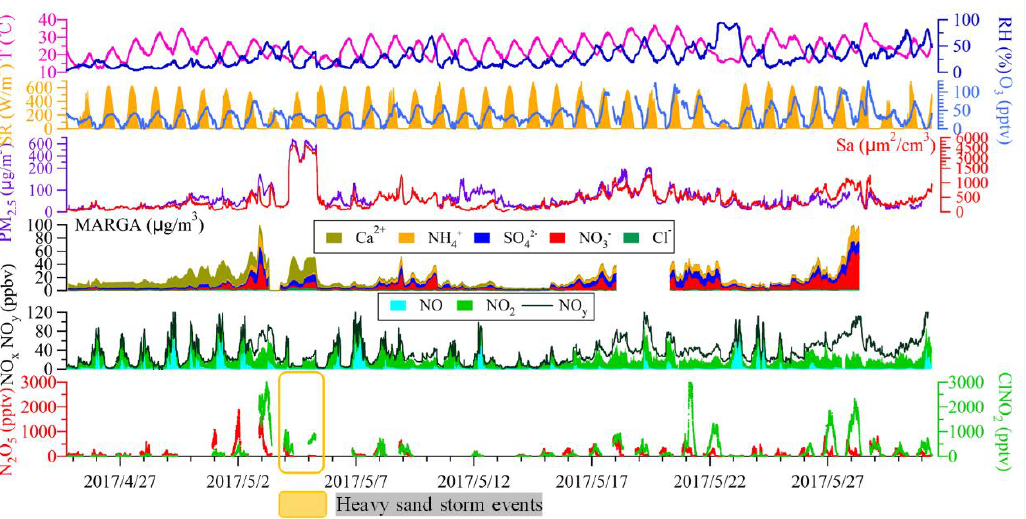
Figure 2. Time series of N 2 O 5 , ClNO 2 , related species, and meteorological parameters from 24 th April to 31 st May 2017. The sampling period in orange denotes a heavy sand storm event. Data gaps are caused by technical issues with the instruments or calibration.